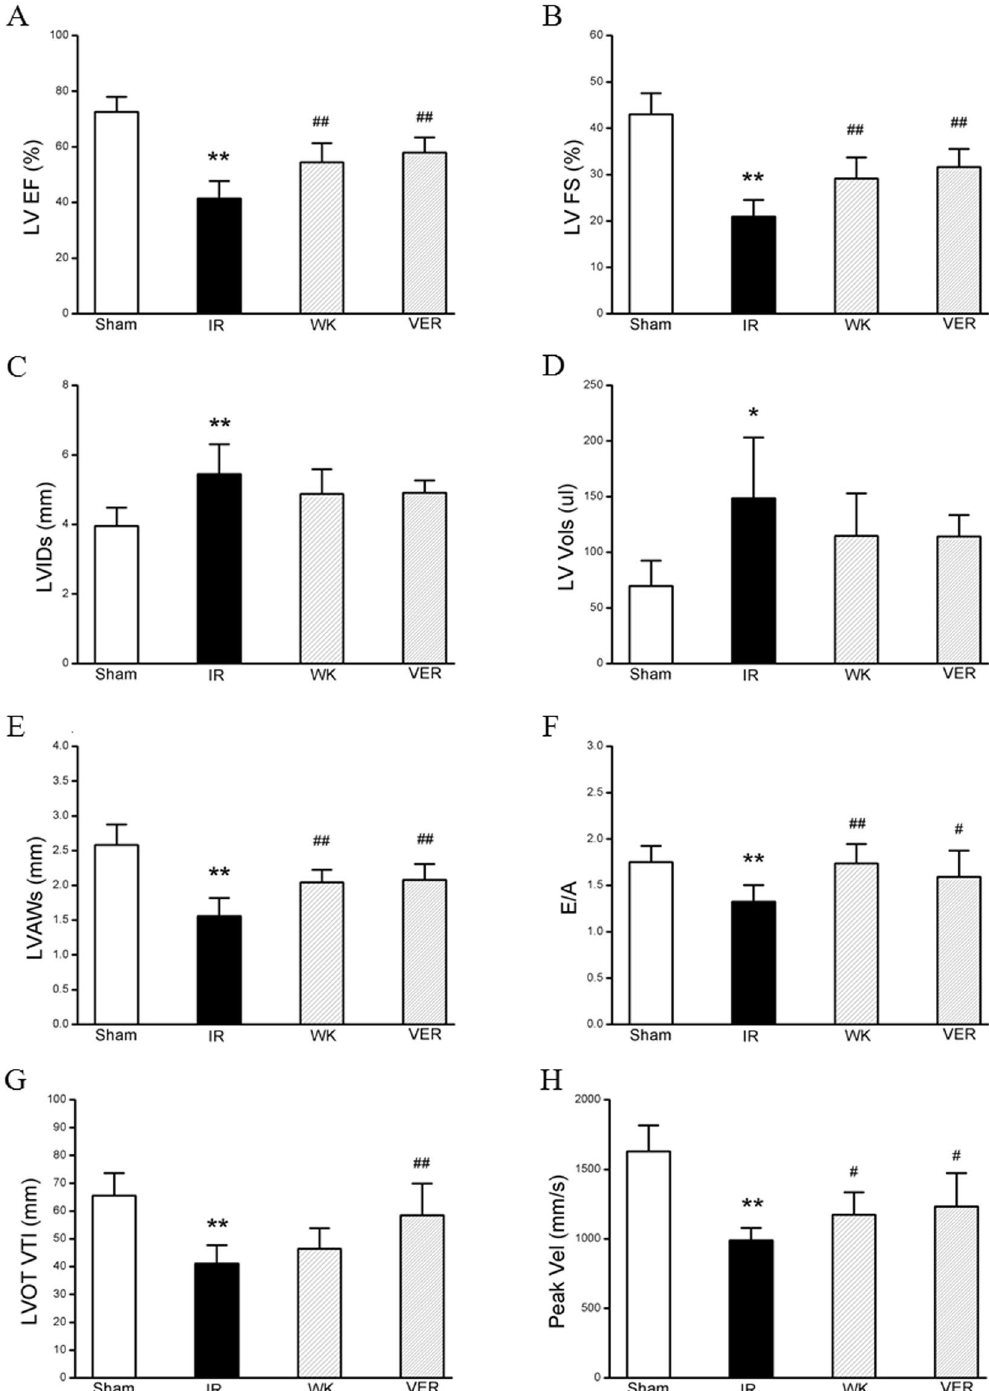
Figure 1. Effects of WXKL and verapamil on rat cardiac function. Quantitative assessment of dilation and systolic function as ( A ) left ventricular ejection fraction (LVEF), ( B ) left ventricular fractional shortening (LVFS), ( C ) left ventricular end-systolic dimension (LVIDs), ( D ) left ventricular systolic volume (LV Vols), ( E ) left ventricular end-systolic anterior wall (LVAWs), ( F ) ratio of E-wave to A-wave (E/A), ( G ) aorta velocity time integral mean velocity (AoV VTI), and ( H ) aortic valve peak velocity (Peak vel). Data are expressed as means ± S.D.; * p < 0.05, ** p < 0.01 versus sham group; # p < 0.05, ## p < 0.01 versus model